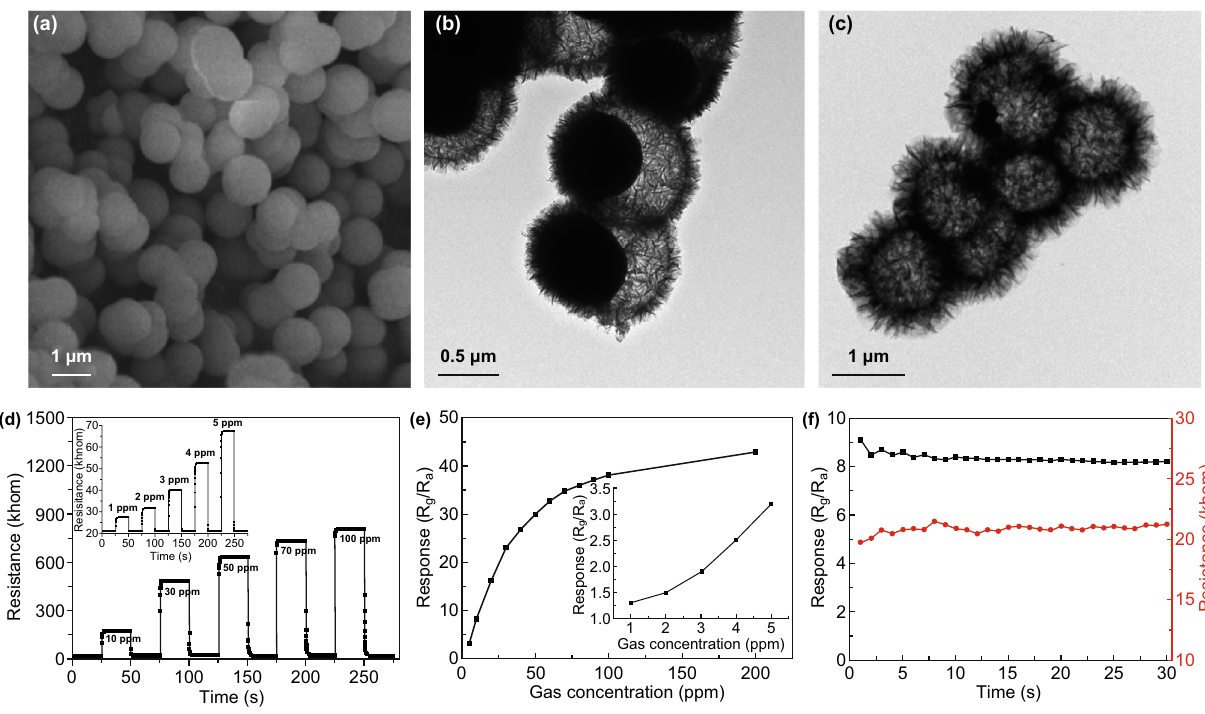
Fig. 8 a SEM image of the Co 3 O 4 microspheres, b, c TEM images of the hollow Co 3 O 4 microspheres showing that the microspheres are com- posed of 2D nanosheets, d dynamic gas sensing transients of the sensors to ethanol with different concentrations at 220 °C. e Response of the sensor to various ethanol concentrations at 220 °C. f Long-term stability of the sensor to 30 ppm ethanol at 220 °C. Adapted with permission from Ref. [201]. Copyright 2017